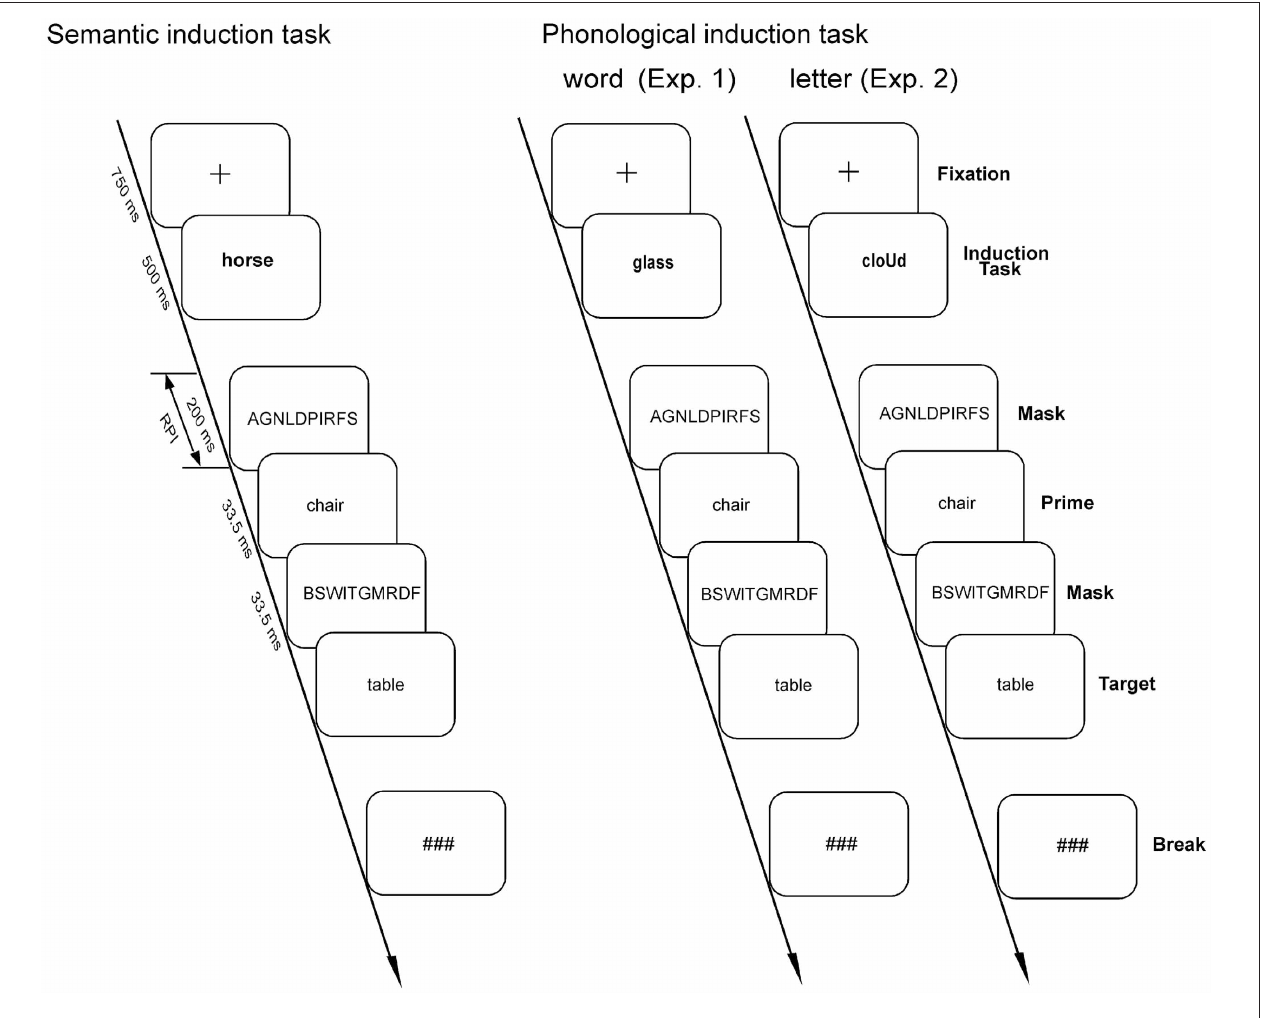
FIGURE 1 | Temporal sequence of one trial in the semantic and phonological induction task conditions of Experiments 1 and 2. The semantic induction task in Experiments 1 and 2 required semantic classification (living/non-living object), whereas the phonological word induction task in Experiment 1 required a phonological word classification